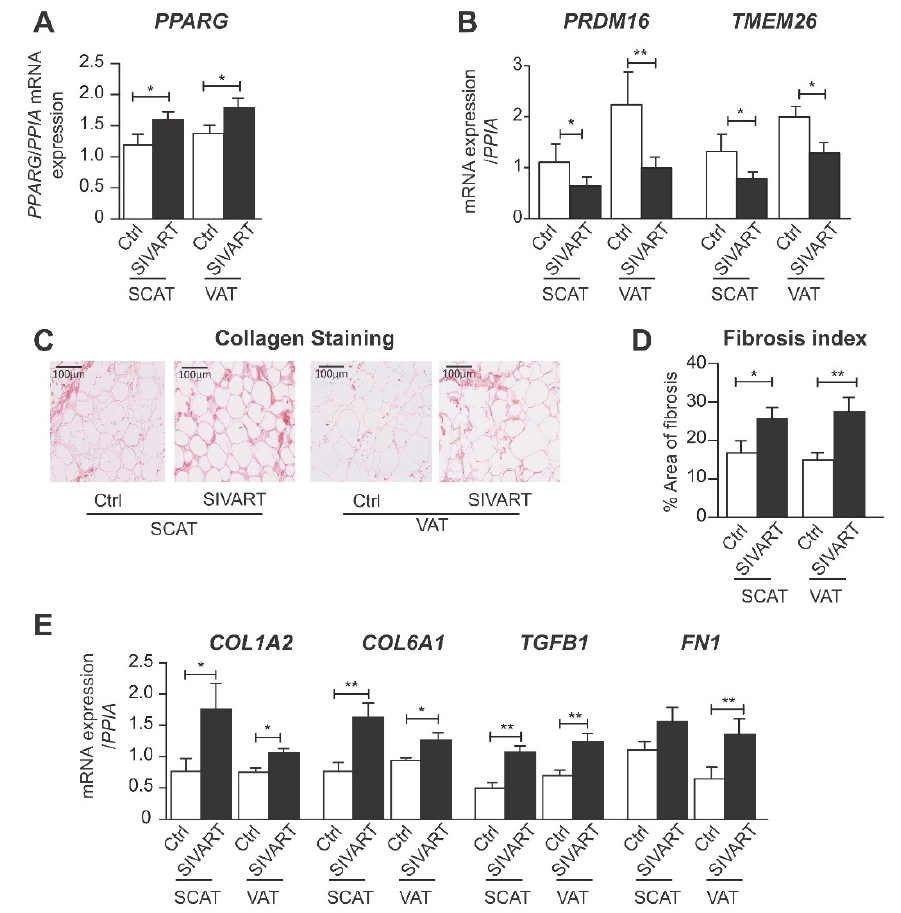
Figure 1. Subcutaneous and visceral adipose tissue from SIV-infected dolutegravir-treated macaques exhibit higher expression of PPARG and fibrosis-related genes and lower expression of beige adipocyte markers. Relative mRNA expression levels (in SCAT and VAT) of ( A ) peroxisome proliferator-activated receptor gamma (PPARG). ( B ) Positive-regulatory-domain-containing-16 (PRDM16) and transmembrane protein 26 (TMEM26) were normalized against that of peptidylprolyl isomerase A ( PPIA ). The results are expressed as the mean ± SEM PCR experiments performed in duplicates using SCAT and VAT from nine control uninfected and untreated macaques (Ctrl) and eleven SIV-infected and ART-treated macaques (SIVART). ( C ) Light microscopy analysis of adipose tissue depots stained with Sirius red to detect collagen fibers. Representative photographs are shown (scale bar, 100 µ m). ( D ) The index of fibrosis was determined using a semi-automatic image analysis system in at least three randomly chosen regions, measured as described in the ‘Material and Methods’ section, using SCAT and VAT from seven control and ten SIVART macaques. ( E ) Relative mRNA expression levels of collagens, COL1A2, COL6A1, transforming growth factor beta 1 (TGFB1), and fibronectin 1 (FN1) normalized against that of PPIA . PCR experiments performed in duplicates using SCAT and VAT from nine control and eleven SIVART macaques. The results are expressed as the mean ± SEM. * p < 0.05, ** p < 0.01, vs. control